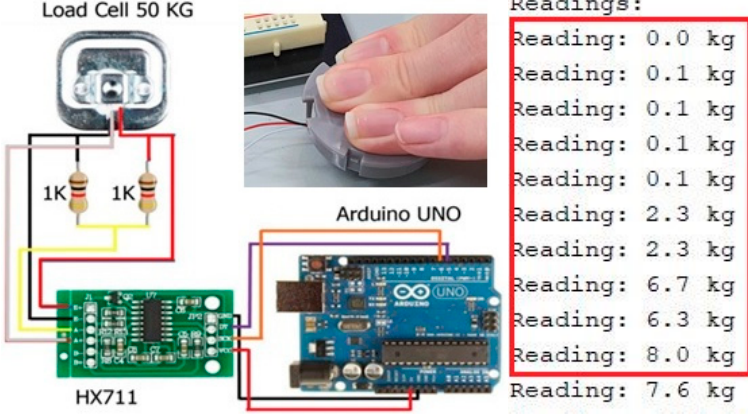
Figure 5. Example of a weight-measuring module with a single load-cell.